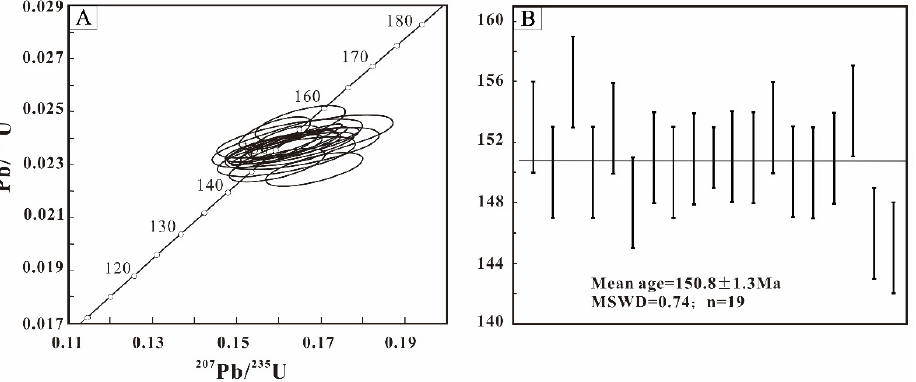
Figure 9. Zircon U-Pb concordia diagram ( A ) and weighted average diagram ( B ) for the andesitic lithic crystal tuff from the Qiyimuchang deposit.